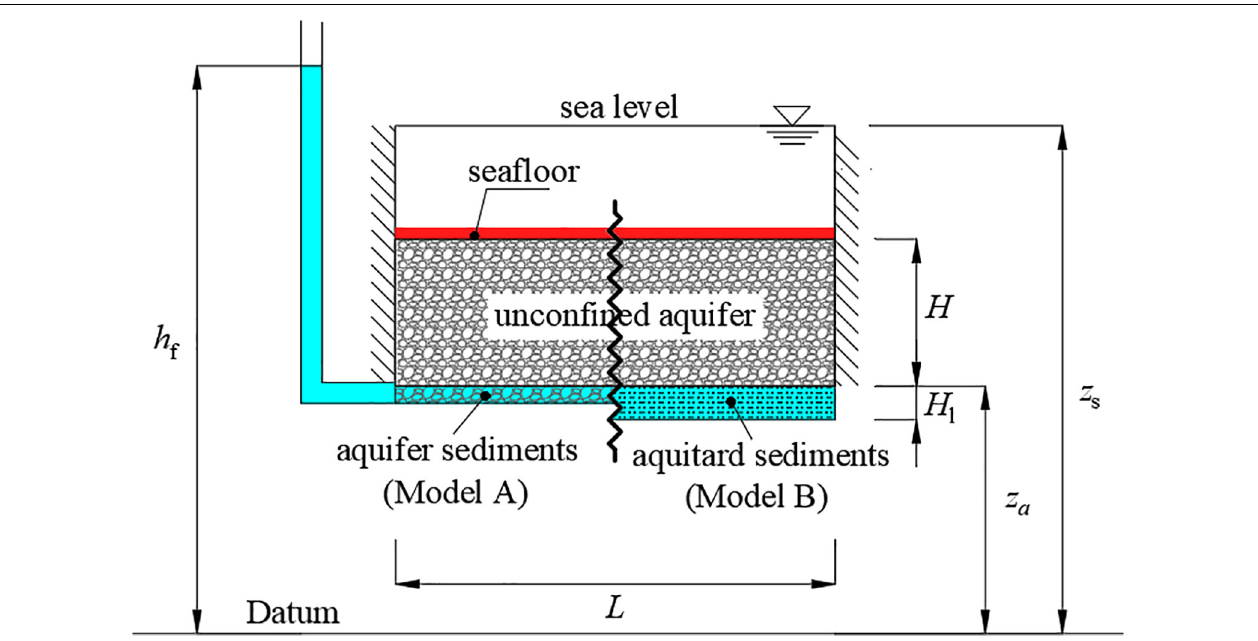
FIGURE 2 | Conceptual models for the numerical implementation of SFGD through an unconfined subsea aquifer, where the left side shows sandy sediments overlying a subcropping, higher-permeability aquifer, and Model B represents an aquitard overlain by sand. Red and blue represent seawater and freshwater boundary conditions, respectively. The equivalent freshwater head at the base of the aquifer, when the aquifer is seawater-filled (i.e., the initial condition), is shown as h f